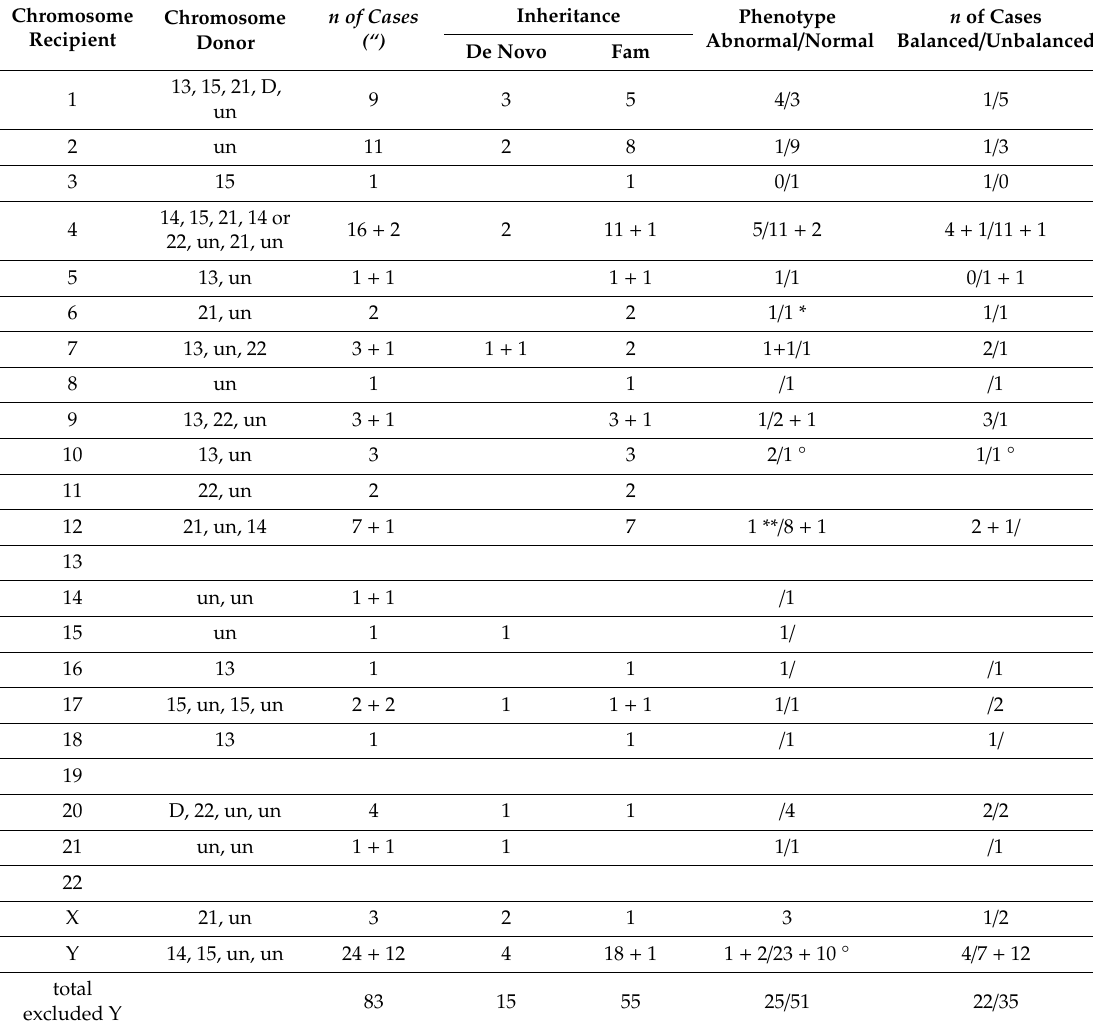
Table 1. Summary of cases from literature [14] and described in this